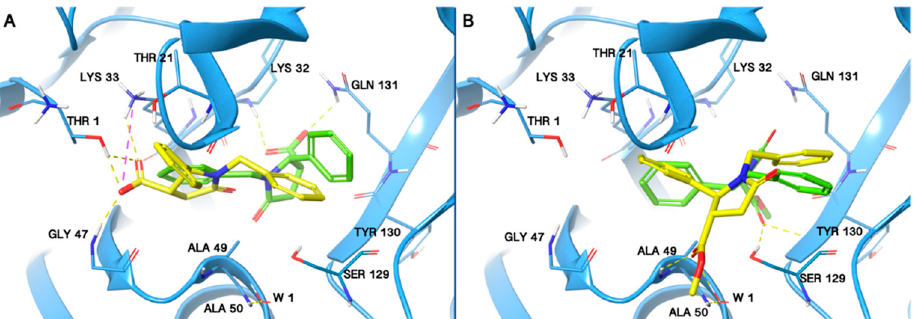
Figure 7. 3D representation of ( A ) ( 2R,3R )- 13 and ( 2S,3S )- 13 and ( B ) ( 2R,3R )- 14 and ( 2S,3S )- 14 complexed in the proteasome chymotrypsin pocket. The proteasome is shown as azure cartoon, the ( 2R,3R )- and the ( 2S,3S )- enantiomers are represented as green and yellow sticks, respectively. The residues involved in crucial contacts with the compounds are reported as azure carbon sticks. The water molecule is shown as red carbon sticks. Hydrogen bonds and salt bridges interactions are reported, respectively, as yellow and magenta dashed lines.